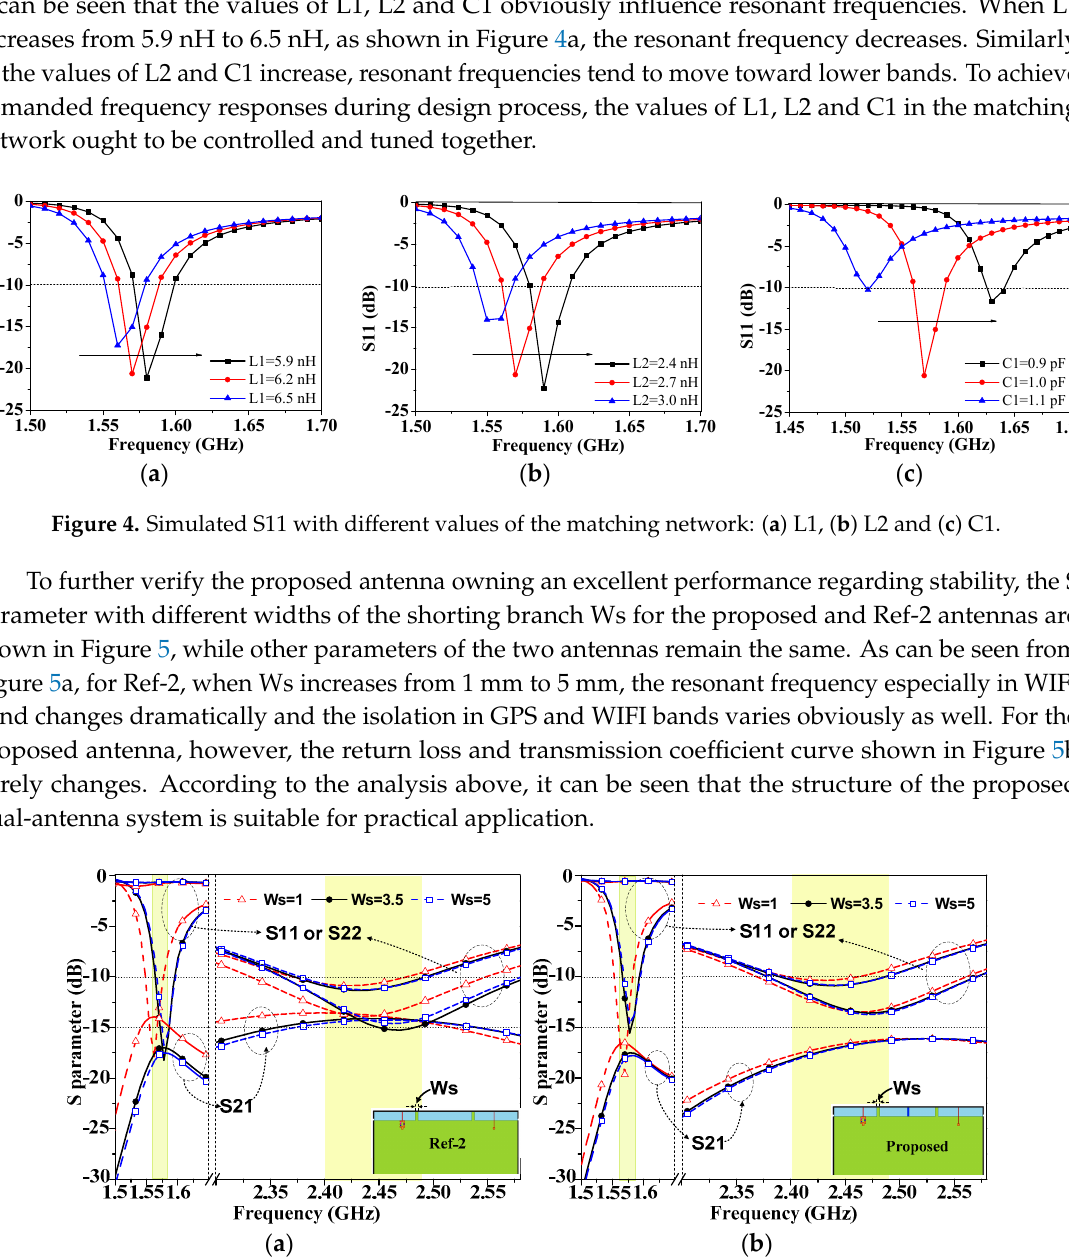
Figure 3. Simulated surface current distributions for proposed antenna with the center shorting strip and the reference antenna but without the middle shorting strip.